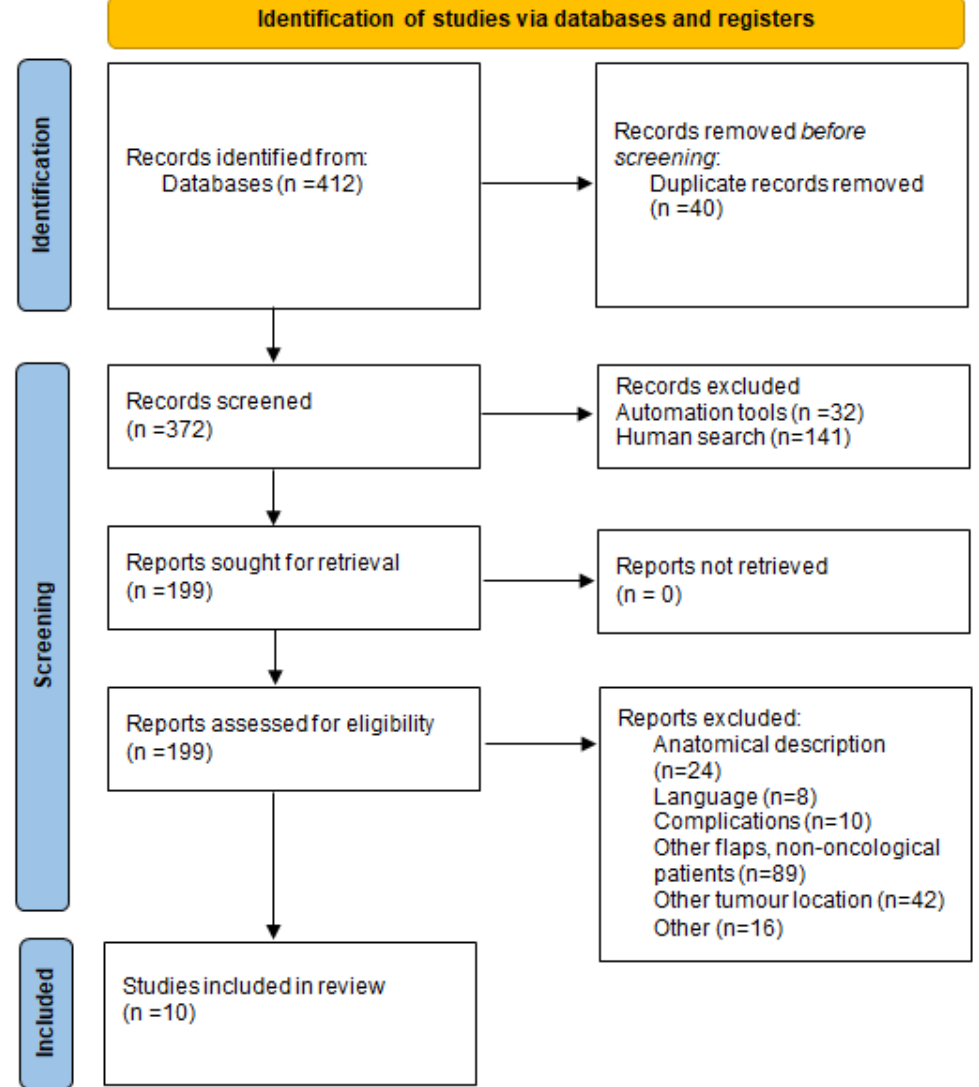
Figure 3. Prisma 2020 flow diagram [8].